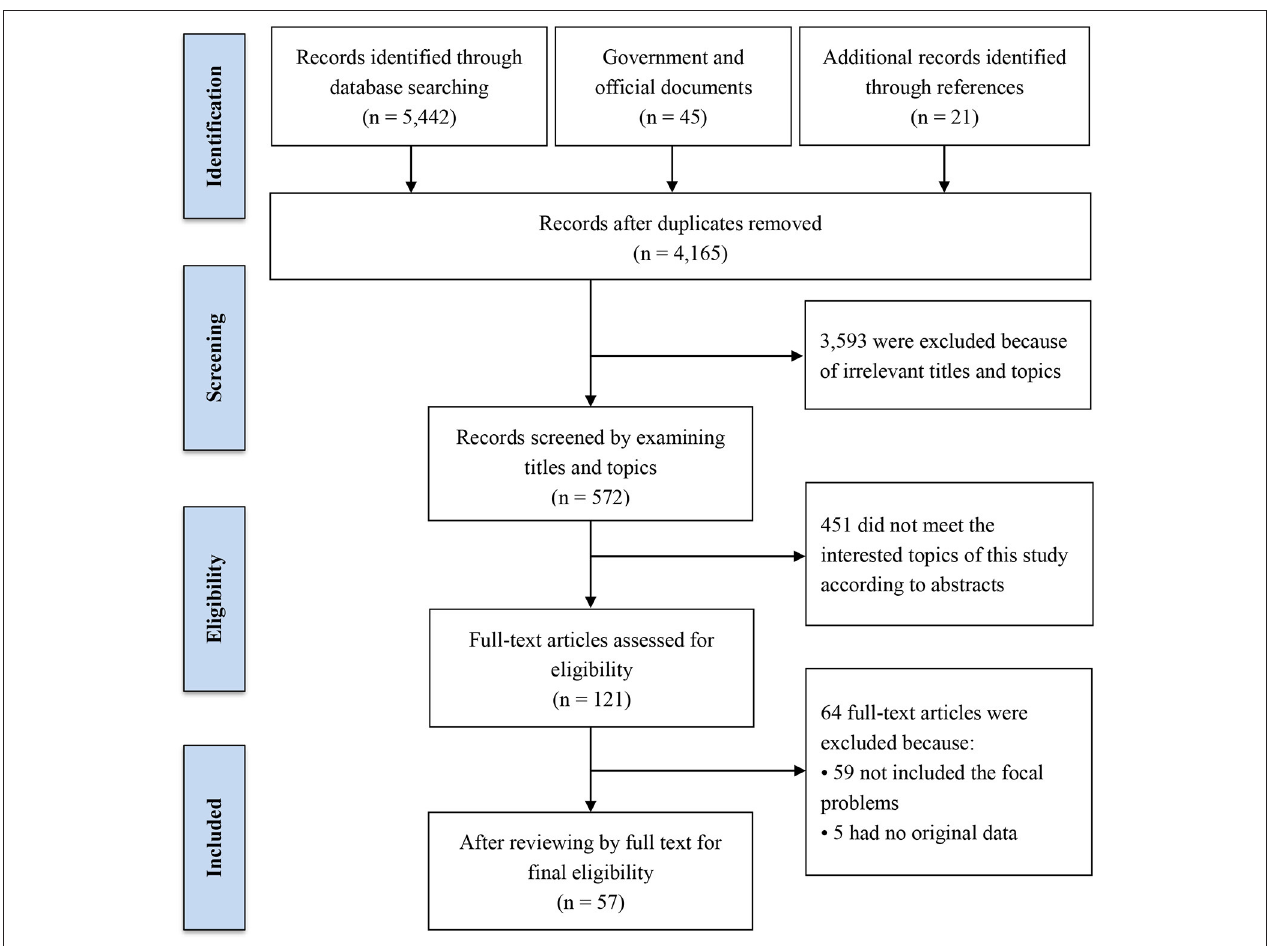
FIGURE 1 | Flow chart of screening process of the literature